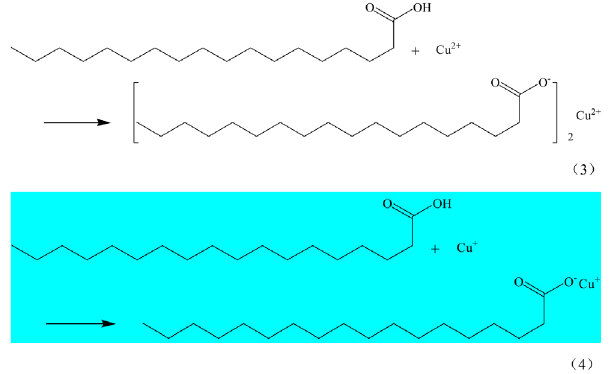
mesh, and the reaction equation is as follows (Eqs 3, 4).